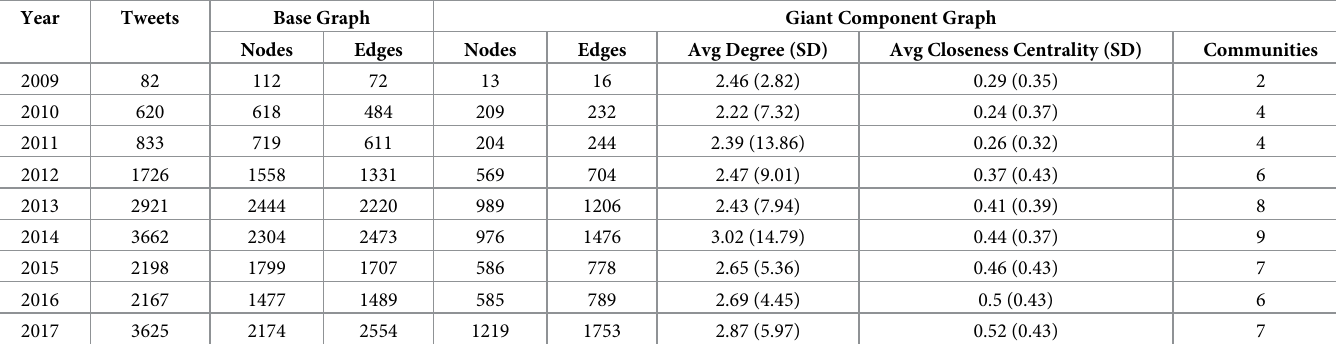
Table 1. Measures for base graphs depicting growth of probiotics communities on Twitter from 2009–17.